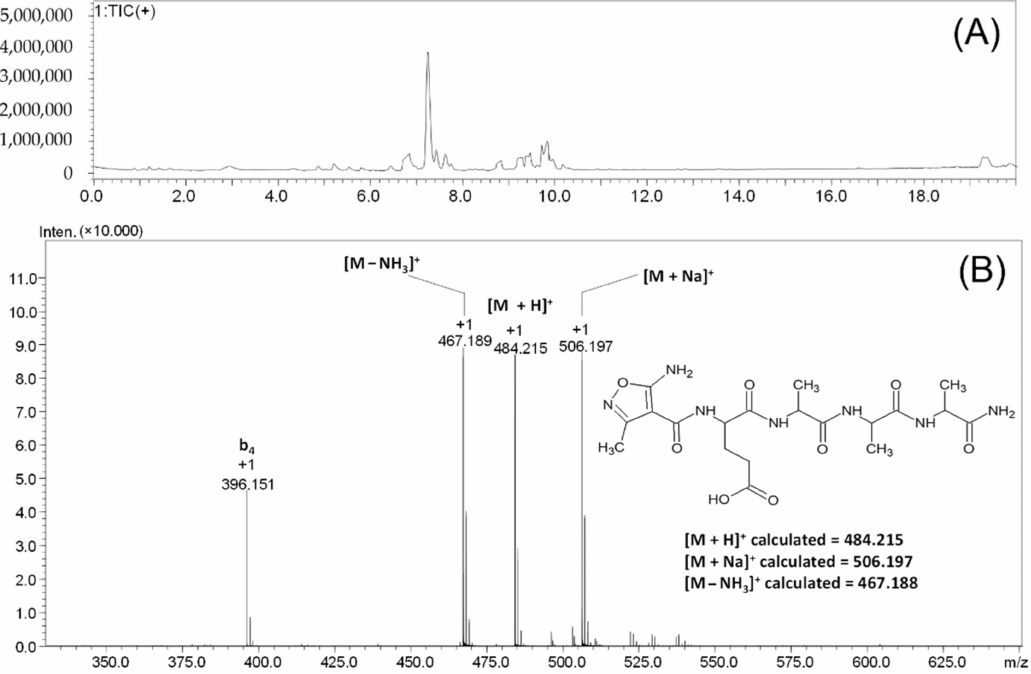
Figure 4. LC-MS analysis of crude product 2 . Total ion current ( A ) and mass spectrum ( B ) of the signal characterized by the retention time of 7.25 min.